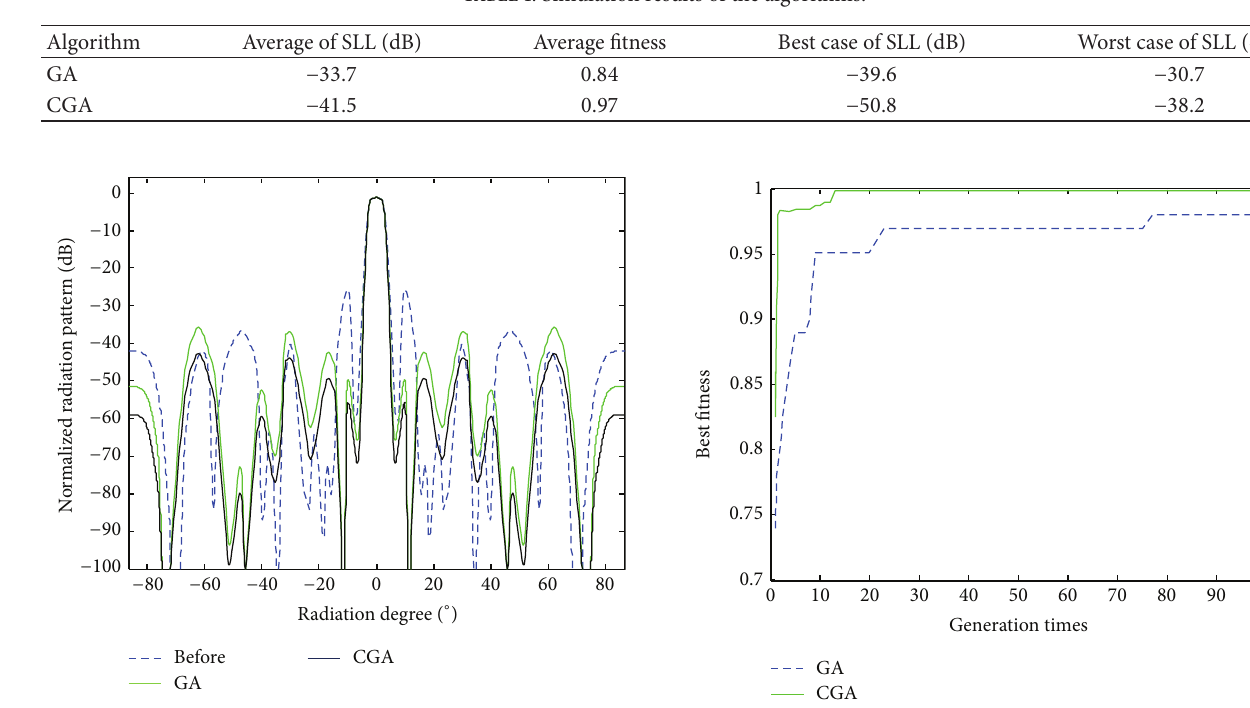
Figure 6: The convergence curves of objective